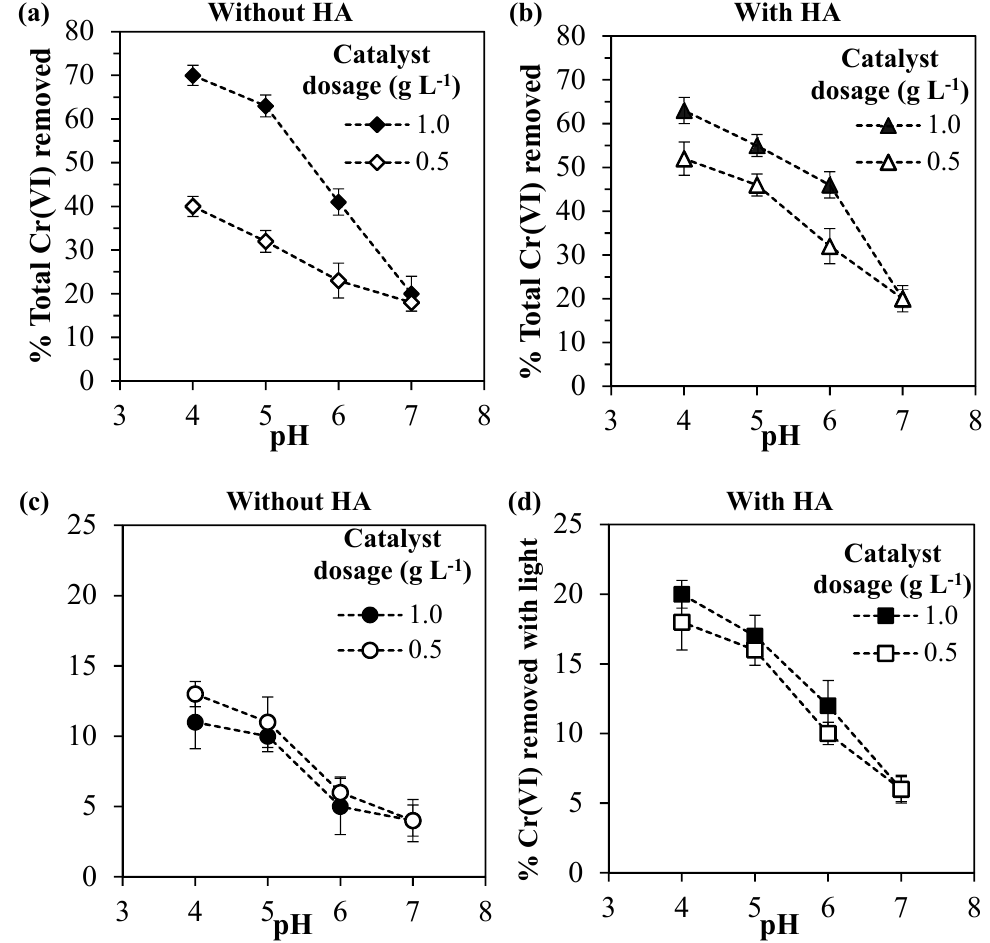
Figure 5. ( a,b ) Total Cr(VI) removed and ( c,d ) Cr(VI) removed by photoreduction for different pH values and catalyst dosages for the systems: (a,c) without humic acid and (b,d) with 10 mg L − 1 of humic acid.